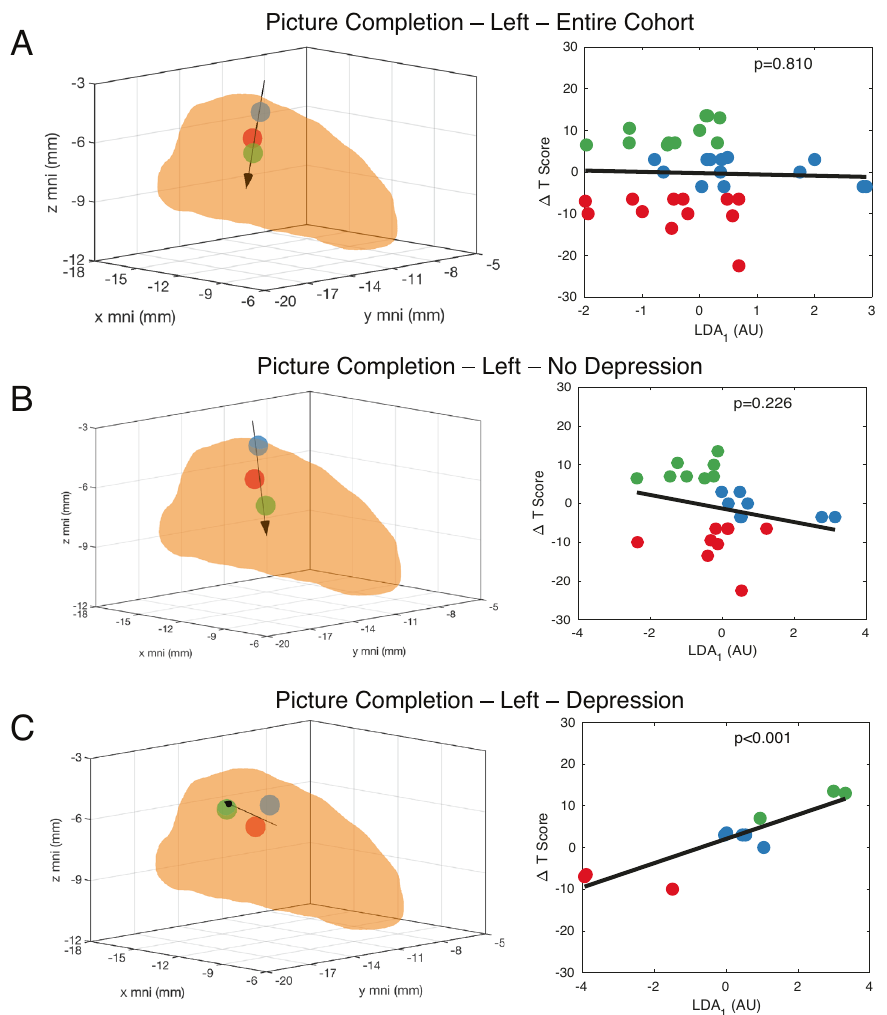
Fig. 3 History of depression can moderate relationships between active contact location and post-DBS cognitive change. LDA analysis does not identify a signi fi cant linear relationship between active contact location and postoperative performance (postoperative worsening — red; no postoperative change — blue; postoperative improvement — green) on the picture completion assessment for the entire cohort ( A ) or for the subgroup of individuals without a history of depression ( B ). However, a statistically signi fi cant linear relationship is detected in the subgroup of patients with a history of depression ( C